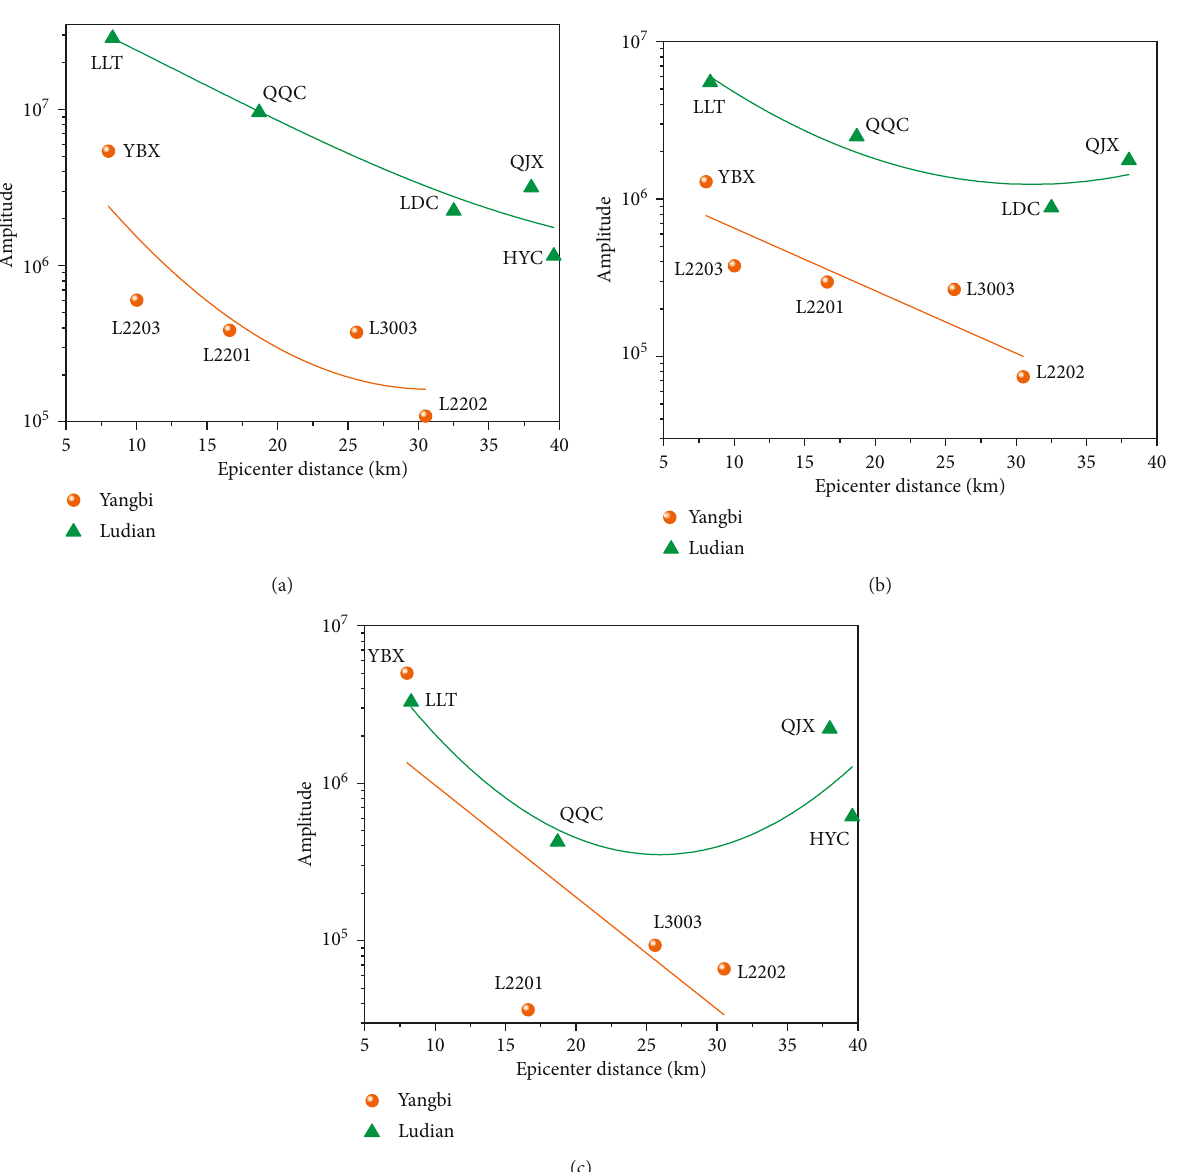
Figure 15: Attenuation of cumulative energy within different frequency ranges of the two events. (a) 0–5Hz. (b) 5–10Hz. (c)